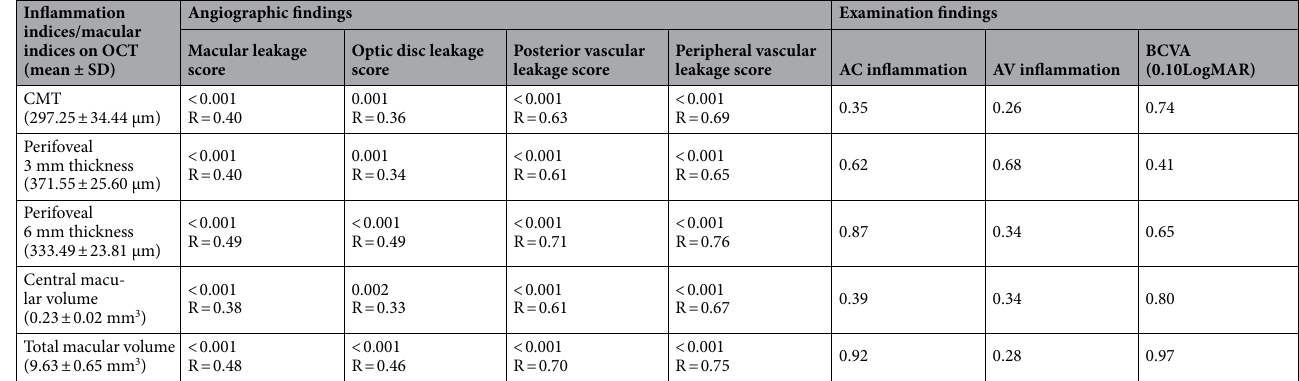
Table 2. The correlation (p values and correlation coefficients) of macular parameters using OCT with angiographic and examination findings. R = Correlation Coefficient.